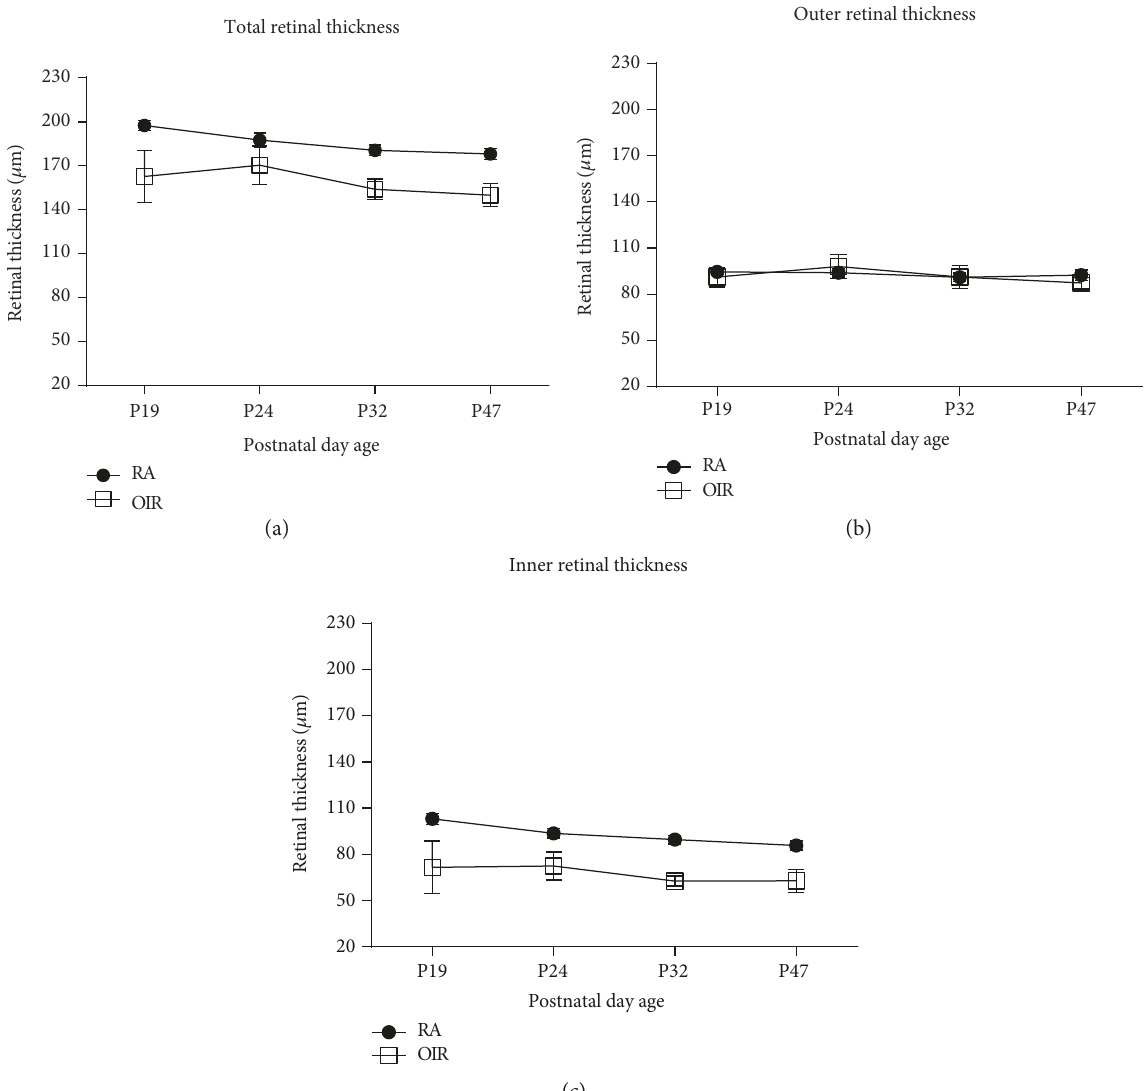
Figure 4: Retinal thickness (total, outer, and inner) at corresponding postnatal day ages of increasing retinal vascular development. (a) Total retinal thickness. (b) Outer retinal thickness. (c) Inner retinal thickness. Note: P refers to postnatal day; RA refers to RA mice; OIR refers to OIR